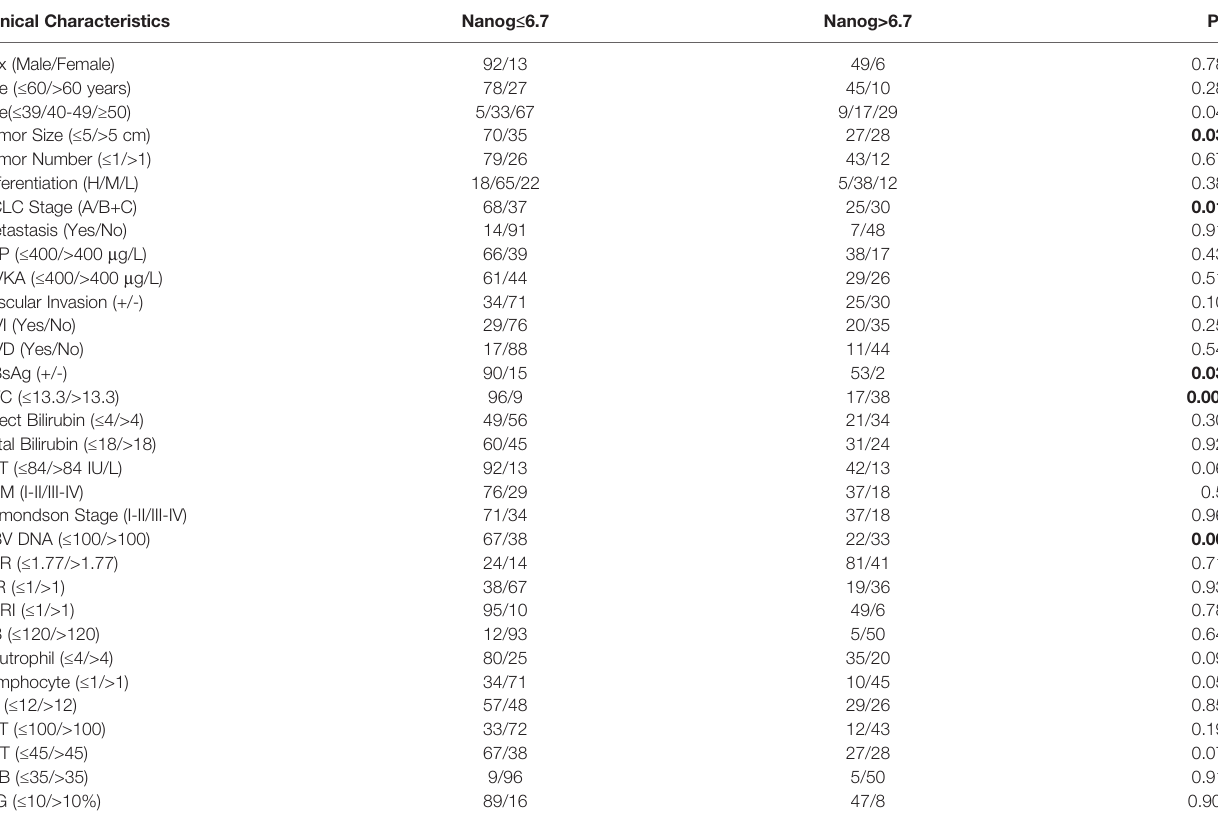
TABLE 2 | Study on the correlation between clinical liver cancer and the total number of Nanog + CSCs. Clinical